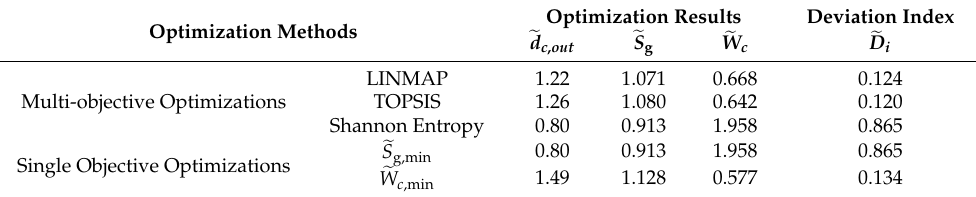
 S  W gained by multi ‐ objective optimization 264 and g c  S and  W gained by multi ‐ objective 265 g c